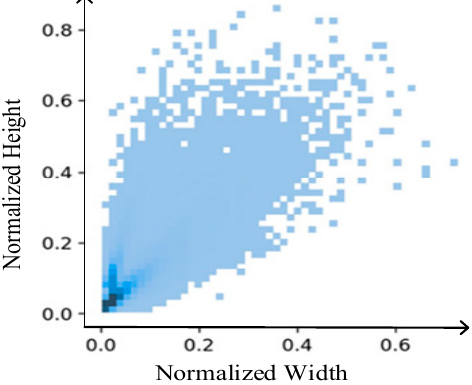
Figure 2. Distribution of sample label scale.